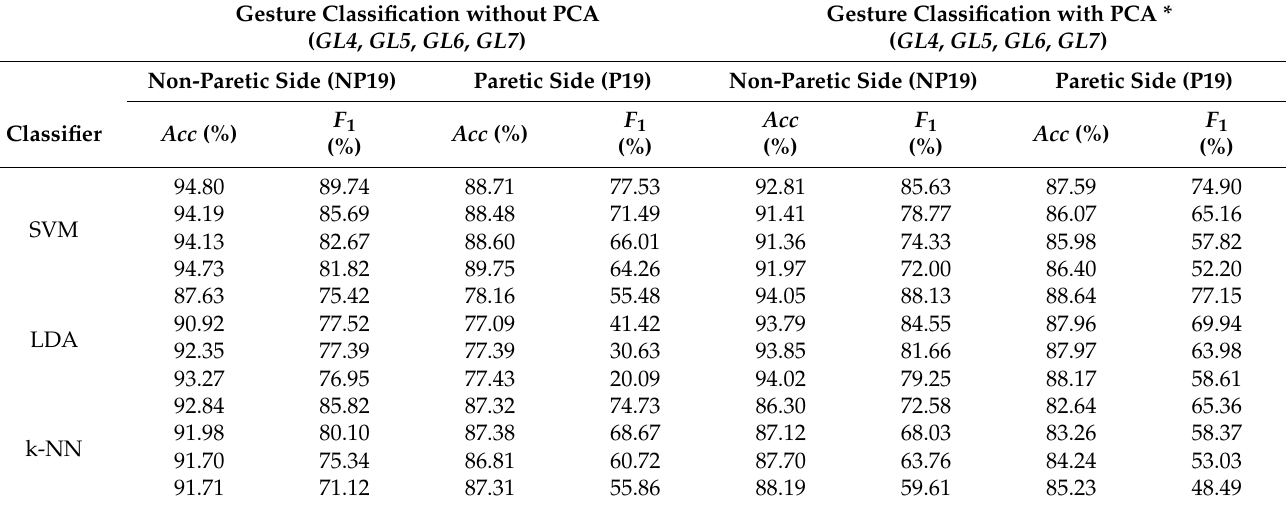
Table 5. Mean average value of accuracy and F 1 scores of supervised gesture recognition from four to seven gesture labels (based on the hand movements of 19 stroke patients) without and with PCA.